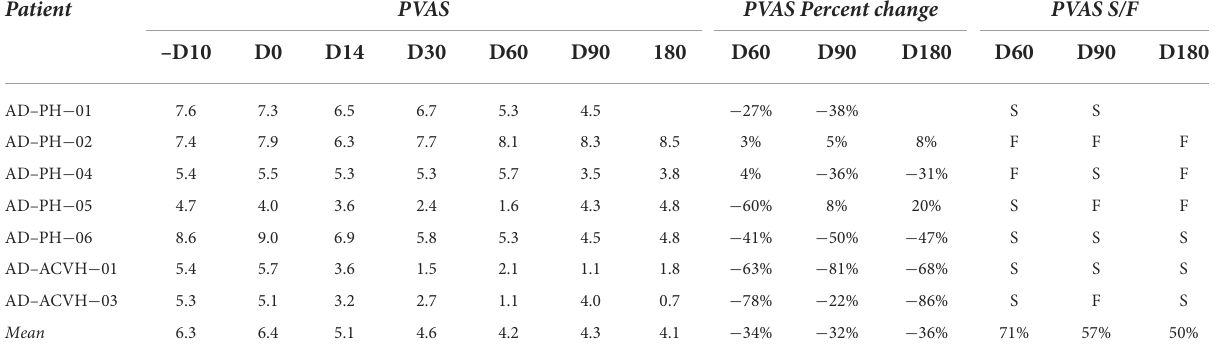
TABLE 2 Individual PVAS scores over time as success (S) or failure (F). Patient PVAS PVAS Percent change PVAS